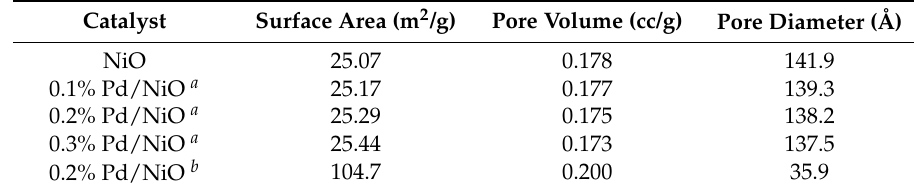
Table 1. Surface parameters of varied catalyst samples with the variations of Pd